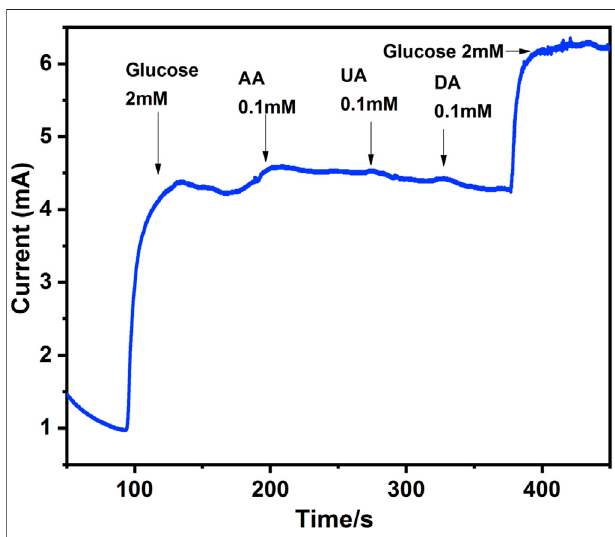
FIGURE 8 | Current responses of Ag@In 2 O 3 modi fi ed NF to 2 mM glucose, 0.1 mM of Ascorbic Acid (AA), Uric Acid (UA) and Dopamine